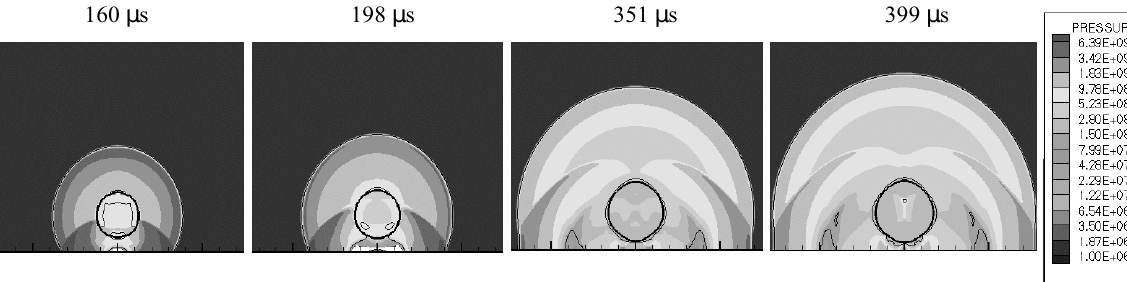
Fig. 13. Rigid flat plate cavitation formation and